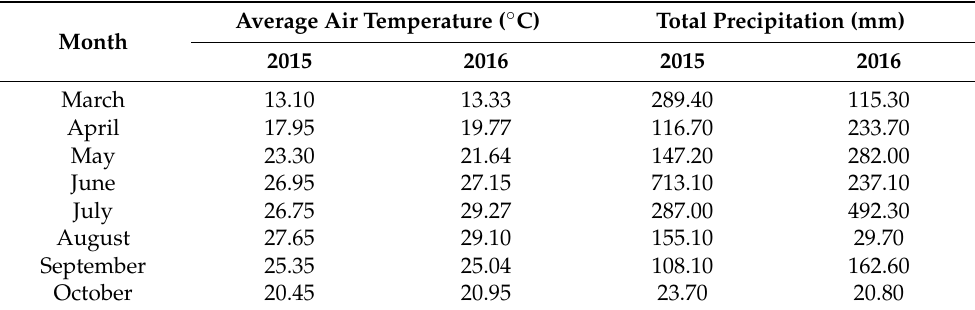
Table 1. The average air temperature and total precipitation from March to October.